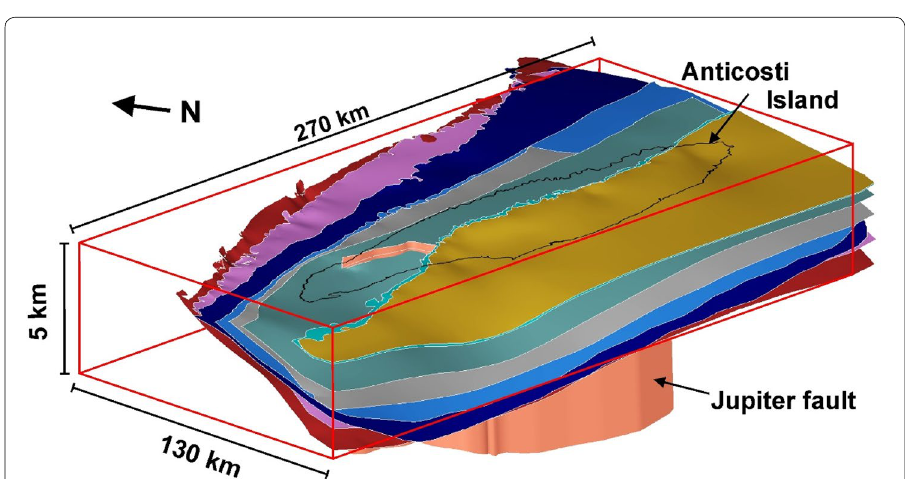
Fig. 6 Thermal unit tops of the 3D geological model. The sub‑vertical plane in orange represents Jupiter fault. See Fig. 2 for color associations of the thermal